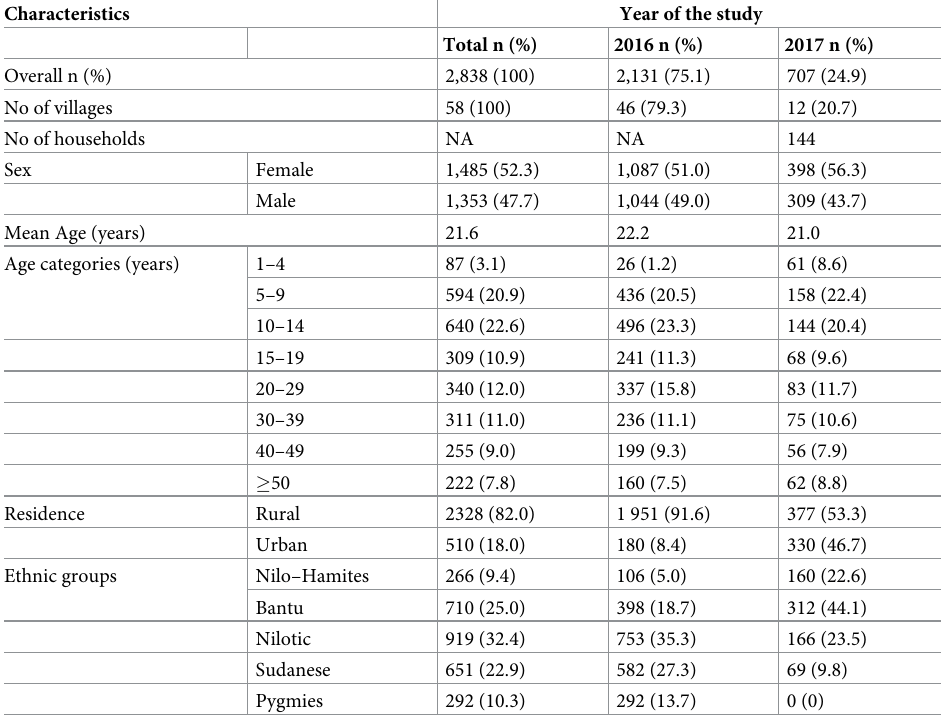
Table 1. Demographic characteristics of the participants in Ituri province in 2016 and 2017.